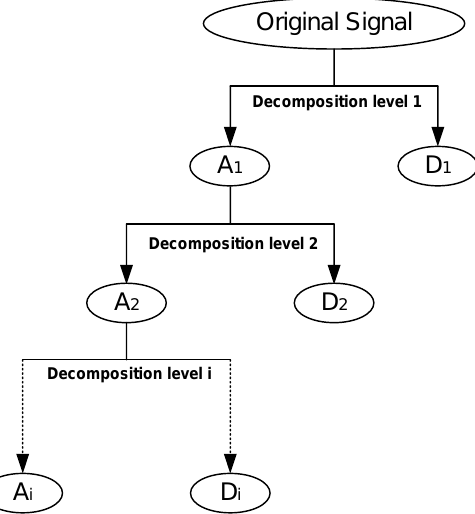
Figure 9. Wavelet analysis decomposition level. Sensors 2023 , 23 , x FOR PEER REVIEW